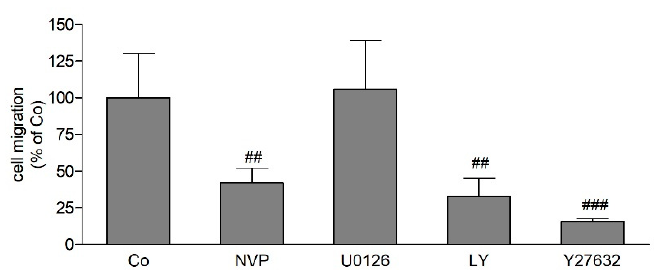
Figure 6. Effect of CerK, MEK, phosphoinositide 3-kinase (PI3K), and RhoA-dependent protein kinase (ROCK) inhibition on migration of CerK-overexpressed parental MDA-MB-231 cells. 5 × 10 4 parental MDA-MB-231 cells transfected with the human CerK cDNA in a pcDNA3.1 vector (CerKoe) cells were seeded onto transwell filters and incubated for 20 h in DMEM/1% FBS in the absence (Co) or the presence of the CerK inhibitor NVP-231 (NVP, 1 μ M), the MEK inhibitor U0126 (10 μ M), the PI3K inhibitor LY294002 (LY, 10 μ M), and the RhoA-dependent protein kinase (ROCK) inhibitor Y27632 (10 μ M). Migrated cells were determined as described in the Methods section. Data are expressed as % of CerKoe control cells and are means ± SD ( n = 3), ## p < 0.01, ### p < 0.001 considered statistically significant compared to the CerKoe control values.